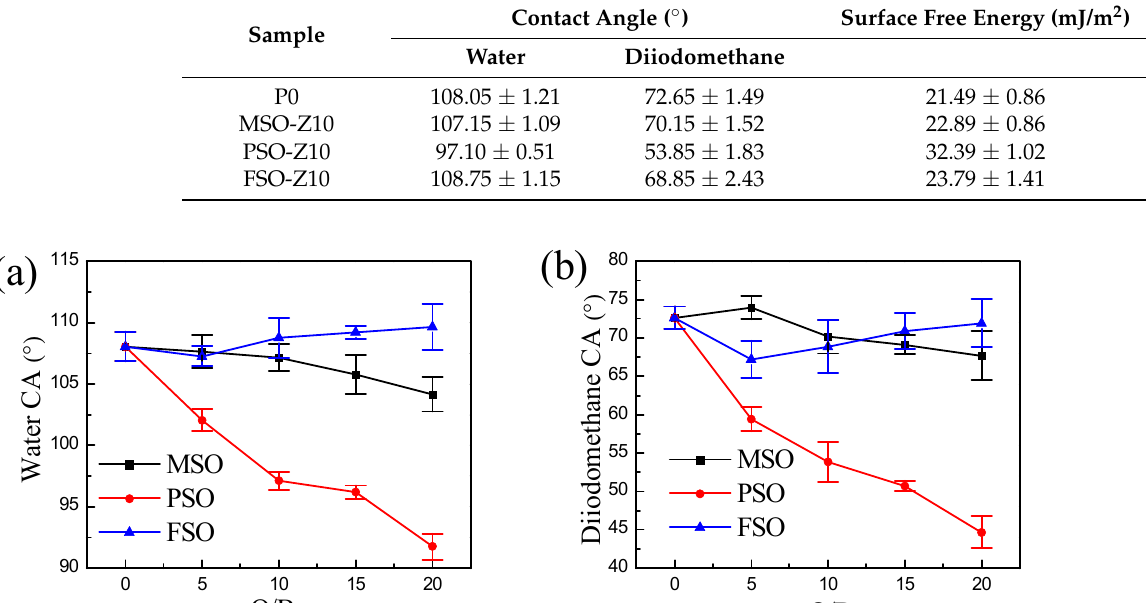
Figure 12. CA changes with O/B in the coatings of different silicone oils, ( a ) water contact angle and ( b ) diiodomethane contact angle.